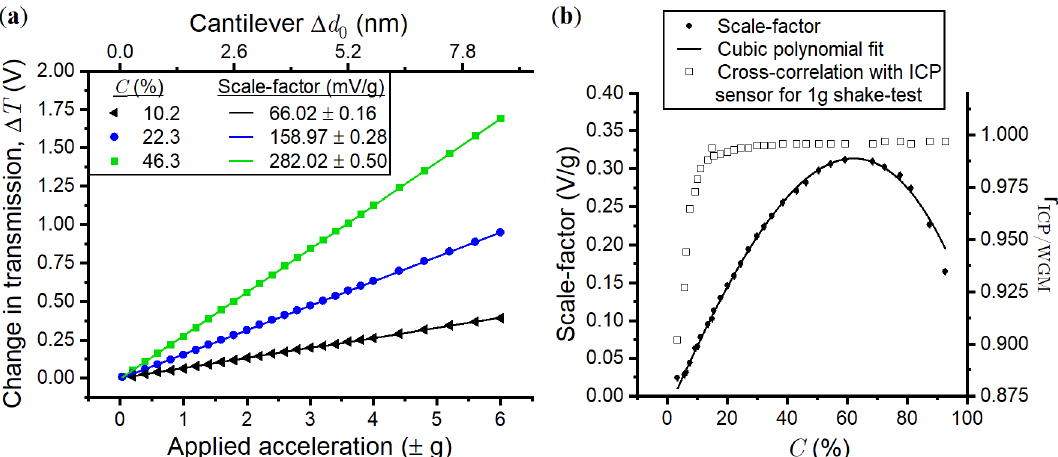
Figure 3. ( a ) The scale-factor is the gradient of the linear fit of the WGM response versus the applied acceleration, shown for three different d 0 defined by the coupling percentage, C . The corresponding cantilever deflection, ∆ d 0 , is displayed as a second x -axis. ( b ) The scale-factor (black circles) as a function of C with a cubic polynomial fit (black solid line). The normalised cross-correlation coefficient, r ICP/WGM (open squares) varies with C with a maximum of r ICP/WGM =